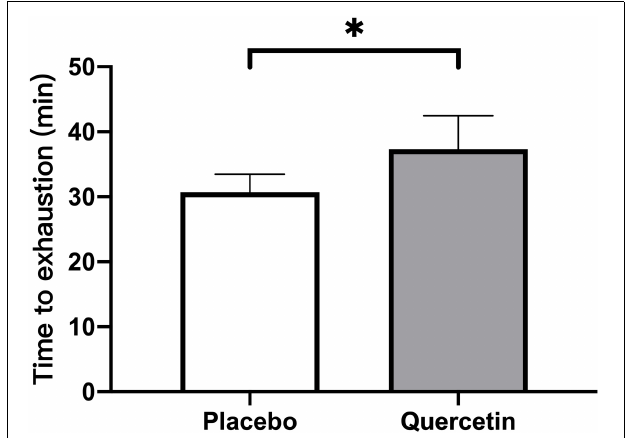
FIGURE 2 | Mean values data of all participants for the time-to-exhaustion tests of the second cycling exercise with 75% VO 2max . ∗ Significant difference between quercetin and placebo ( p < 0.05). Values are expressed as mean ± SE, N =